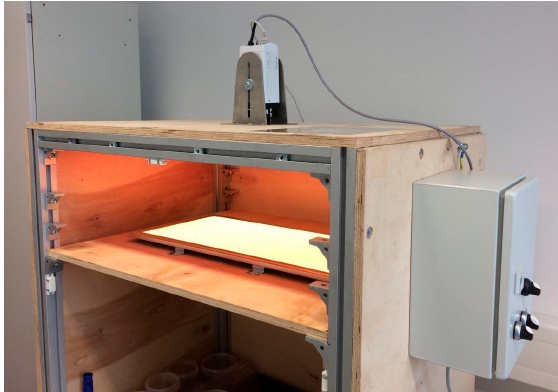
Figure 2. Experimental setup for fuel photography at FAU-EVT (with removed front cover).